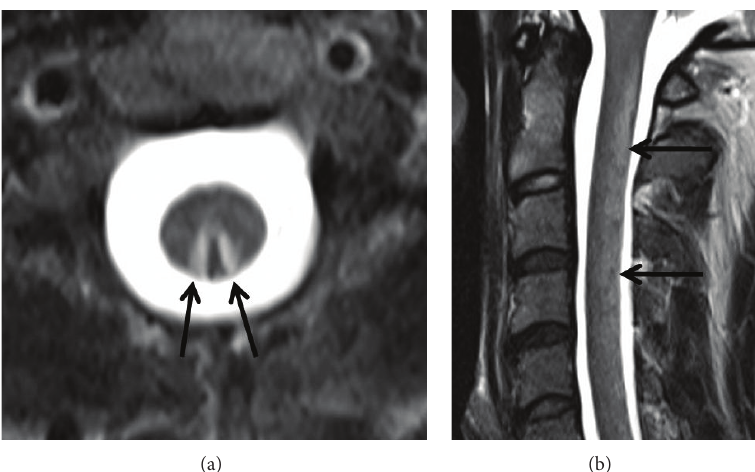
Figure 1: The T2-weighted axial (a) and sagittal (b) images of the cervical spine show hyperintensity (arrows) of the dorsal columns of the spinal cord. There was no contrast enhancement of the lesion (not shown).